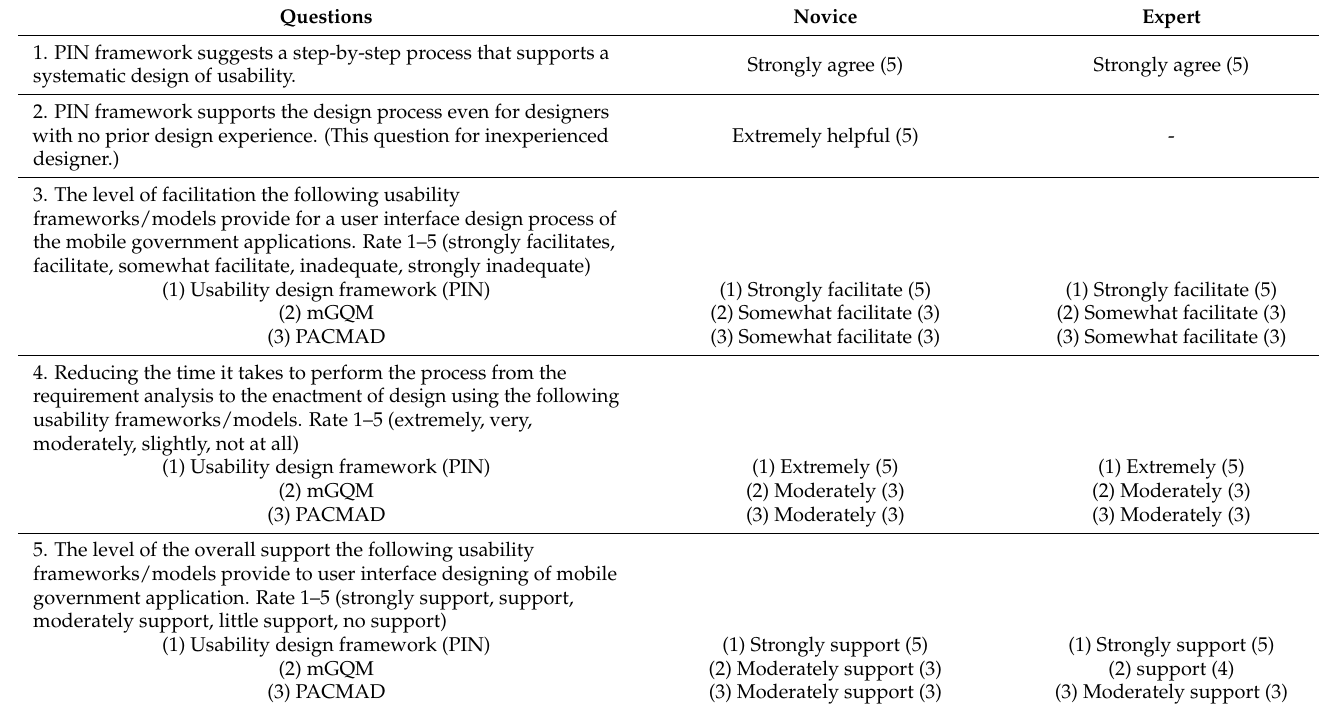
Table 12. The result of the evaluation to validate the usefulness of PIN